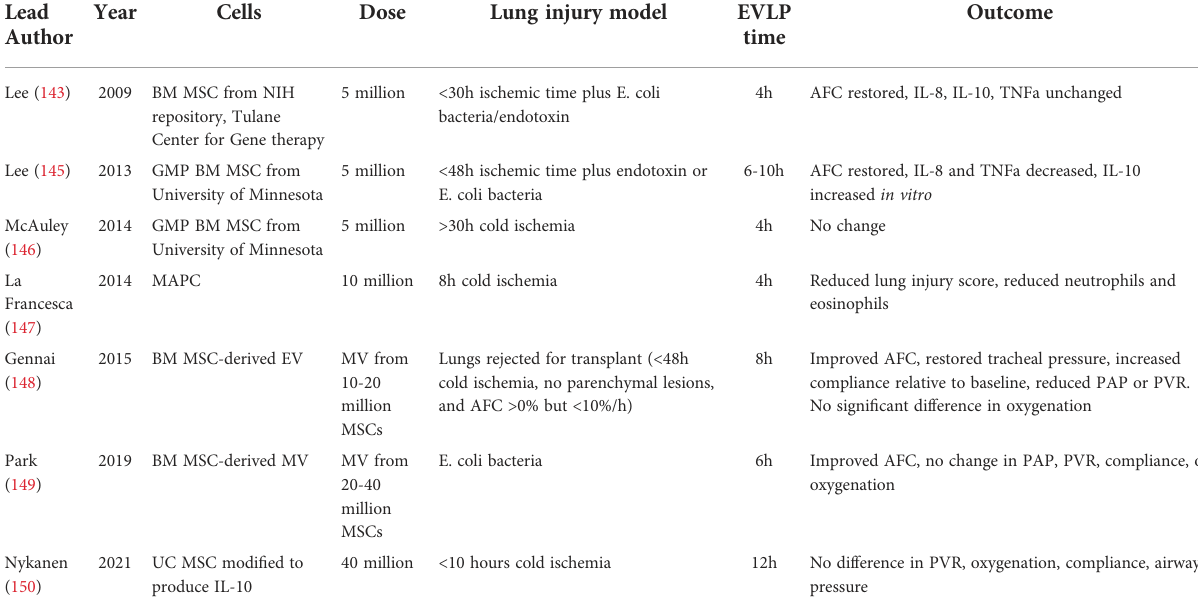
TABLE 1 Studies of mesenchymal stromal cells (MSCs), multipotent adult progenitor cell (MAPCs), and MSC-derived extracellular vesicles (EVs) in human lung ex vivo lung perfusion (EVLP).